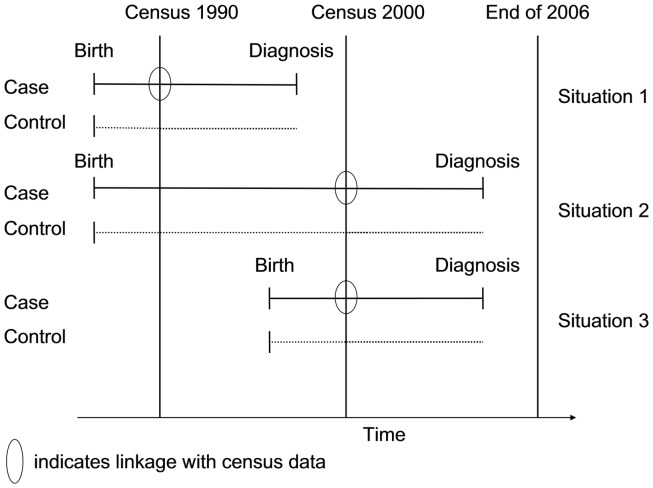
Schematic description of the included cases and controls and the linkage with census information. Only childhood cancer cases born before a census and diagnosed after a census were eligible to be included as cases; controls were matched for year of birth and gender.